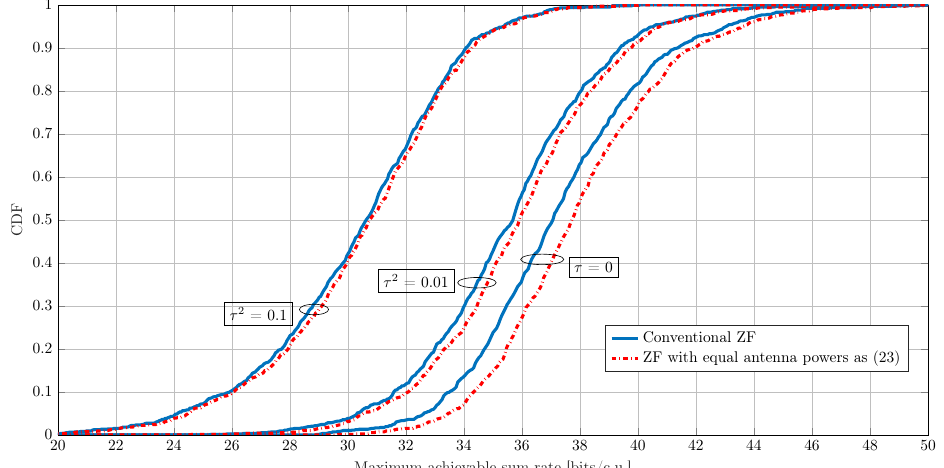
Figure 5. The CDF for the maximum achievable sum rate with P EAP and conventional ZF precoding under different channel estimation qualities τ 2 ∈ { 0,0.01,0.1 } . These sum rate values are achieved over different realizations of the geometric channel (4) for an array with B = 64 antennas and U = 4 UEs. The maximum output power at each PA is ρ ( b ) max = 30dBm, and the maximum power efficiency is η ( b ) max = 0.55 for b = 1, . . . , B . The nonlinearity characteristics of the PAs are as in (2) with K = 1, = 1, and β ( b ) = − 0.0426 − 0.0191 j for b = 1, . . . , B β ( b ) 3 1